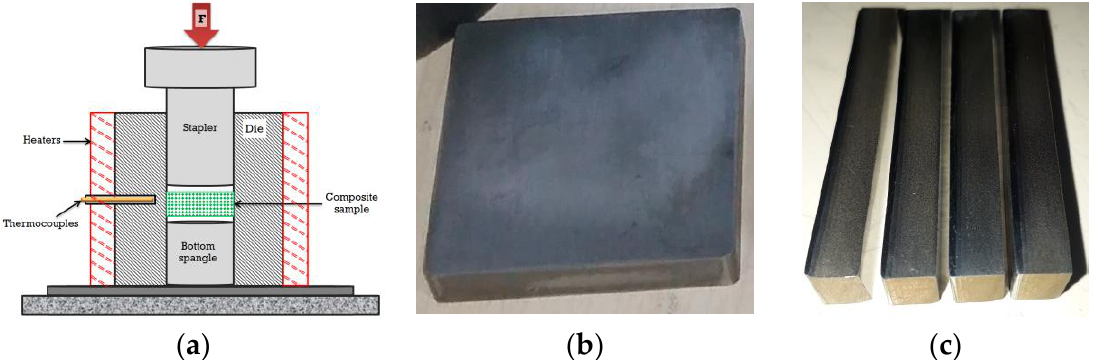
Figure 2. ( a ) Schematic fabrication method of composite specimens under hot-pressing in a square die; fabricated composite specimen: ( b ) compacted Fe + 10% B 4 C after hot-pressing (55 mm × 55 mm × 10 mm); ( c ) sliced and sintered (60 min, 1000 °C) un-notched test specimens (55 mm × 10 mm × 10 mm).